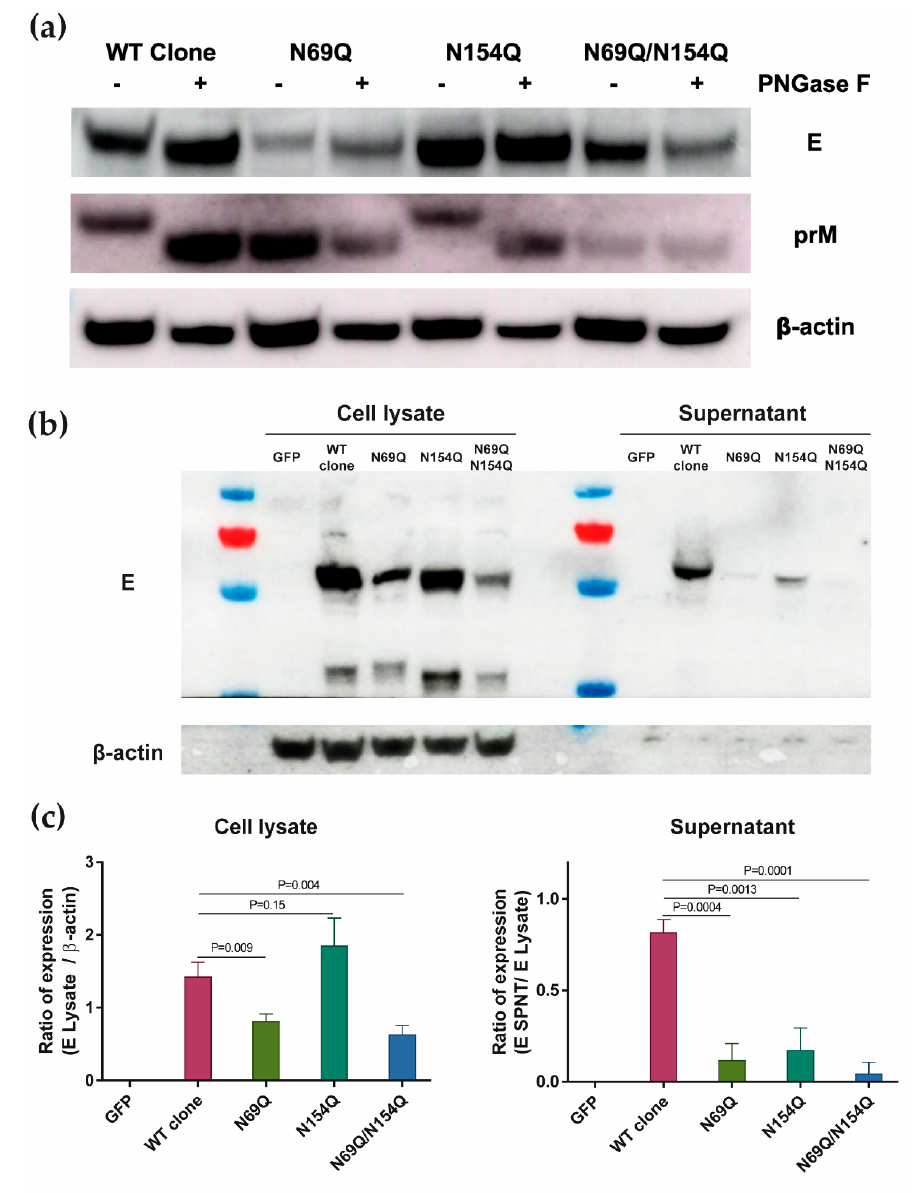
Figure 4. The lack of N -glycan on the pre-membrane (prM) or / and E protein caused impairment in the E protein expression and secretion. ( a ) Confirmation of absence / presence of N -glycosylation in the prM- and E proteins expressed from constructed plasmids. For the Western blotting, proteins were stained with anti-ZIKV E -, anti-ZIKV prM- or anti- β actin protein antibody ( b ) Representative Western blot picture of E- and β -actin protein expression in harvested cell lysate and cell culture supernatant from three independent experiments. ( c ) Quantification of E protein expression with Image J. To normalize the E protein expression in the cell lysate, the expression level of E protein was divided by the expression level of β -actin. To normalize the E protein expression in the supernatant, the expression level of E protein from the supernatant was divided by the expression level of E protein from the cell lysate. The experiment was repeated three times, average and SD are shown. Statistical significance was determined by two-tailed t-test. p = p value. GFP = pcDNA3.1-GFP vector; WT clone = pcDNA3.1-prME vectors with wild-type ZIKV prM-E genes; N69Q = pcDNA3.1-prME vector with a mutated N -glycosylation site in prM; N154Q = pcDNA3.1-prME vector with a mutated N -glycosylation site in E; N69Q / N154Q = pcDNA3.1-prME vector with mutated N -glycosylation sites in prM and E; PNGase F = Peptide:N-glycosidase